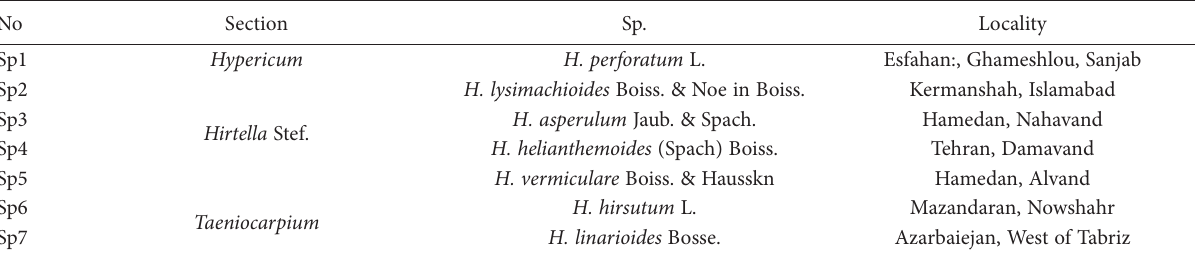
Table 1. Voucher details of Hypericum species in this study from Iran.